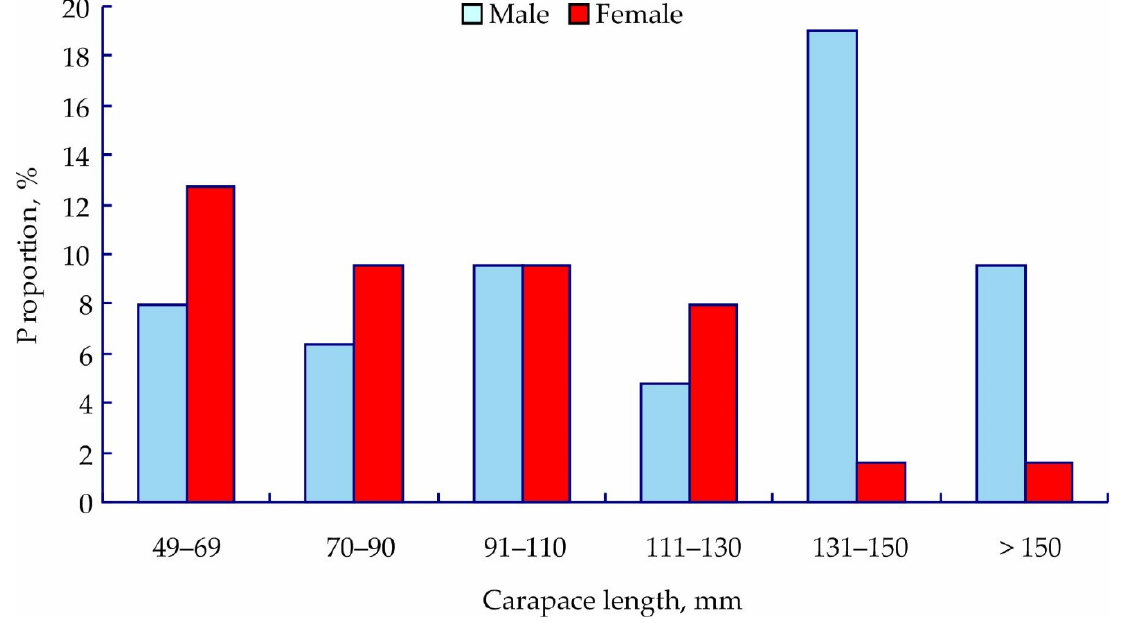
Figure 2. Size–frequency distribution of red king crabs from the coastal Barents Sea. Table 1. Morphometric parameters of red king crabs used for biochemical